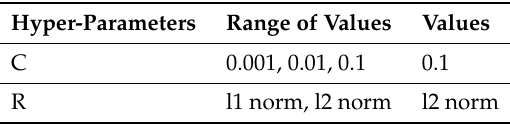
Table 7. Hyper-parameter values of LR.